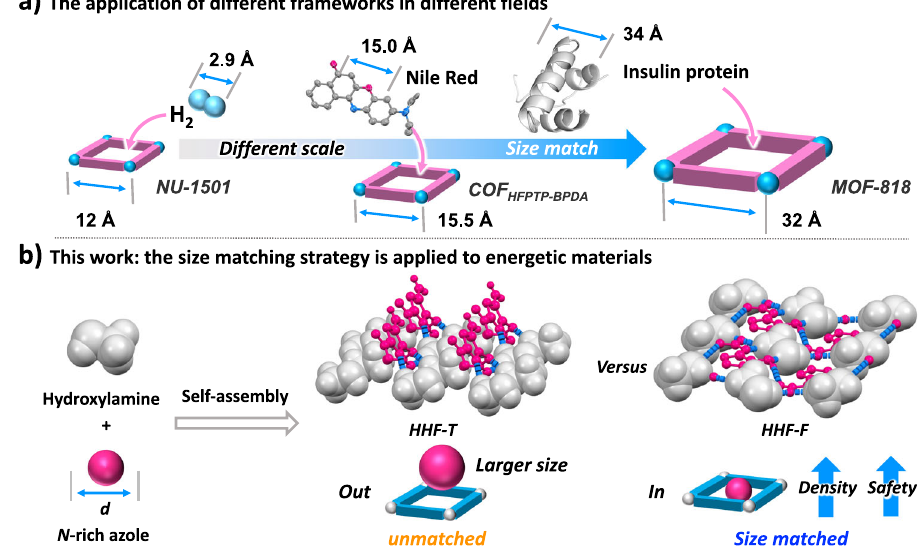
Fig. 1 | The application of size matching strategy. a The application of different frameworks in different fi elds (NU-1501 20 ; COFHFPTP-BPDA 21 ; MOF-818 22 ); b Size- matched hydrogen bonded hydroxylamine framework in energetic materials